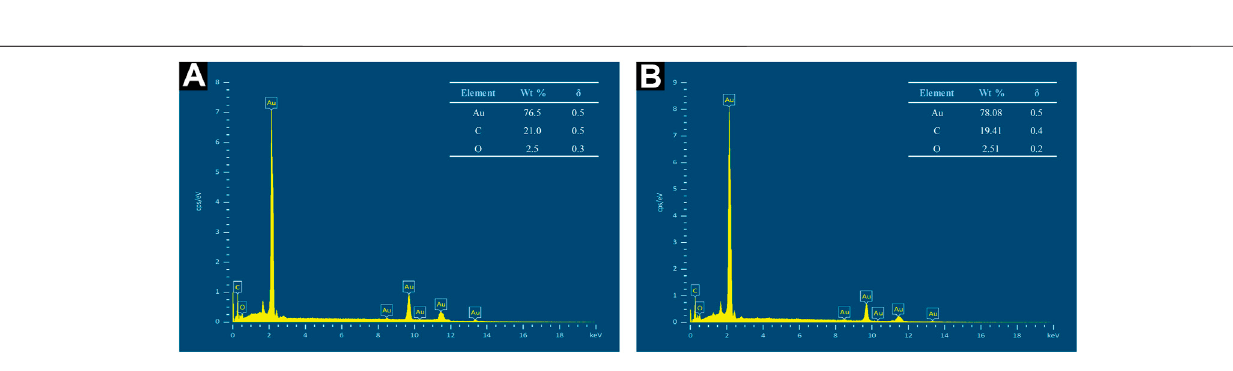
FIGURE 9 | FESEM images and particle size distribution of (A) AuNPs@pH6 and (B) AuNPs@pH10